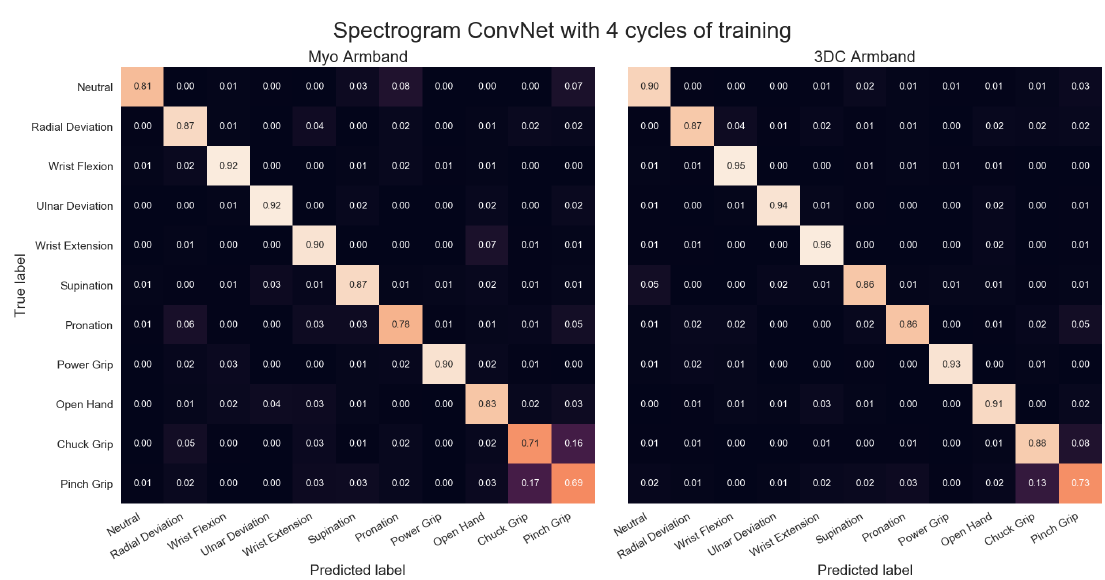
Figure 15. Comparison between the Myo and the 3DC Armband employing the Spectrogram ConvNet for classification: The number of cycles corresponds to the amount of data employed for training (one cycle equals 5 s of data per gesture). The Wilcoxon Signed Rank test is applied between the Myo and the 3DC Armband. The null hypothesis is that the median difference between pairs of observations (i.e., accuracy from the same participant with the Myo or the 3DC Armband) is zero. The p-value is shown when the null hypothesis is rejected (significant level set at p = 0.05). The black line represents the standard deviation calculated across all 22 participants.